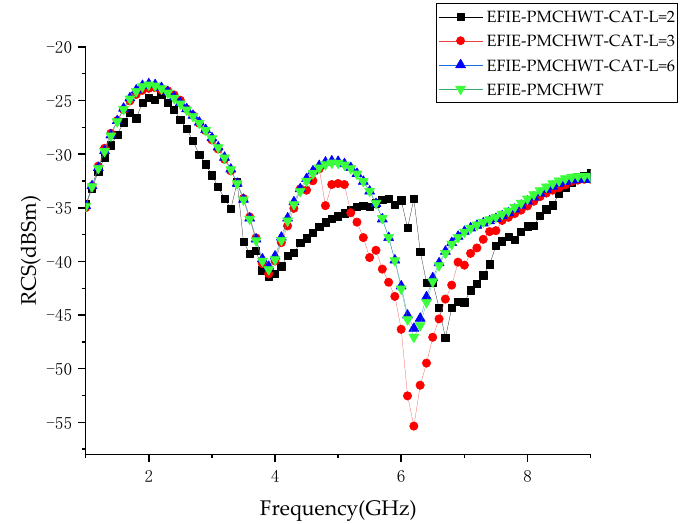
Figure 7. RCS frequency response of the coated target by using three different orders of EFIE- PMCHWT-CAT and EFIE-PMCHWT.